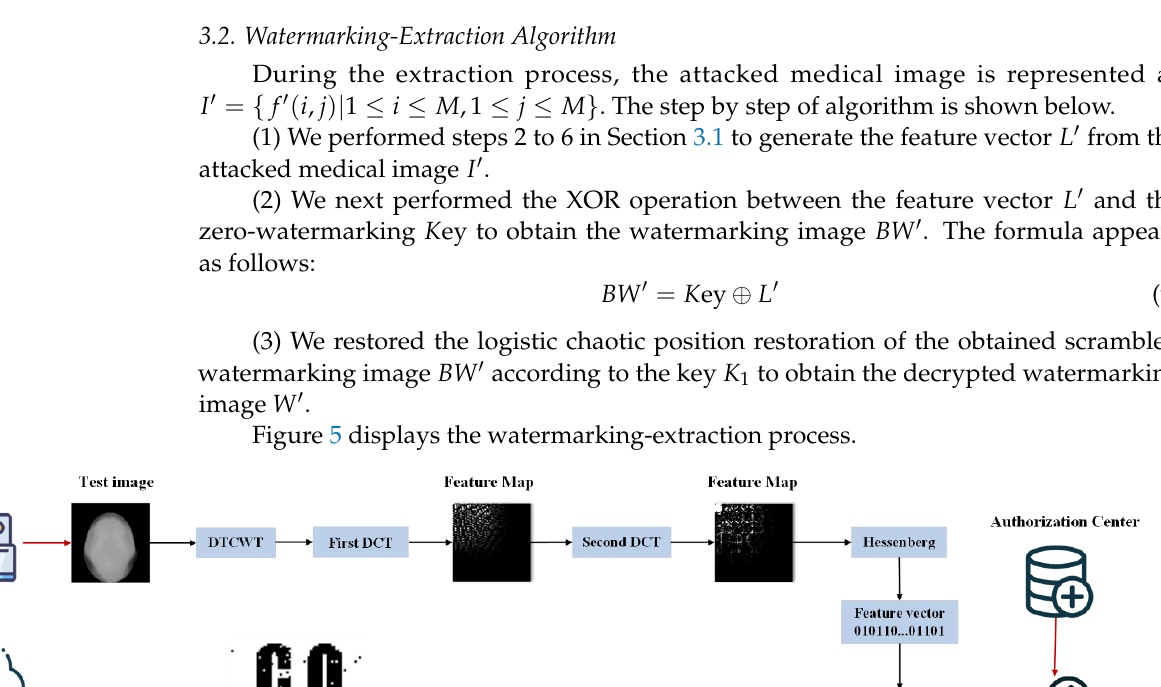
Figure 7a. The key to chaotic encryption is